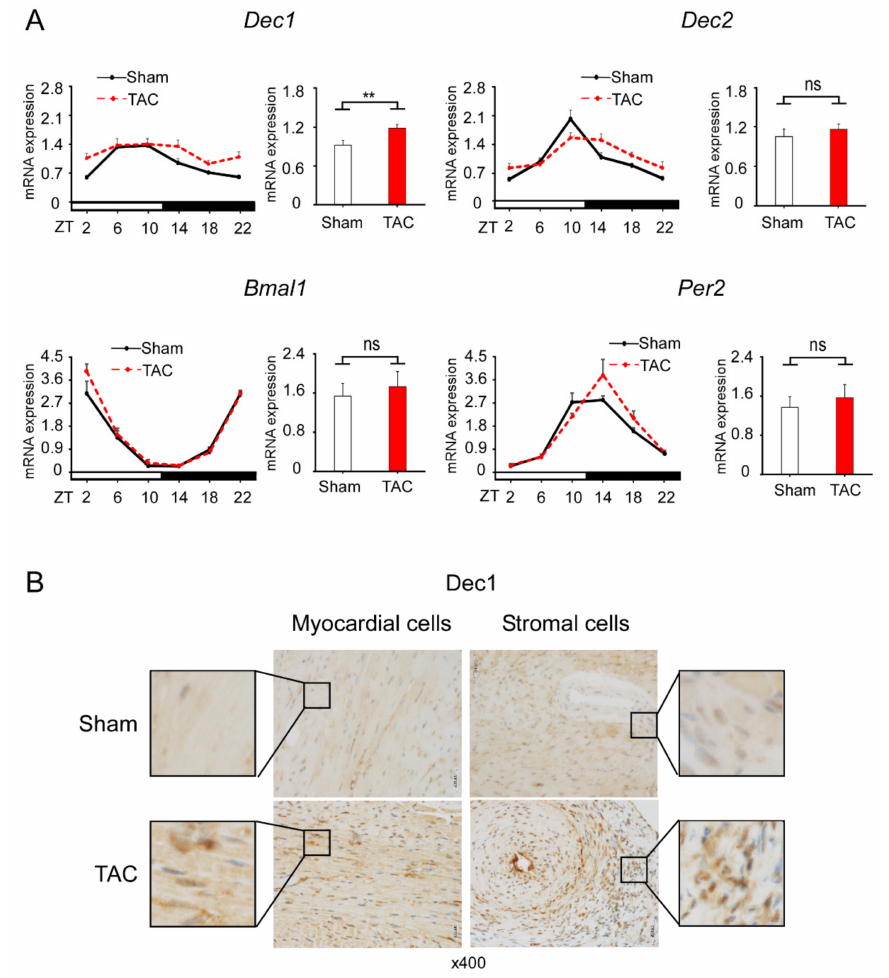
Figure 2. TAC increases Dec1 expression. ( A ) The circadian expression of clock genes in WT mice treated with TAC (red dotted line) and sham treatment (black line). The mRNA levels of Dec1 , Dec2 , brain and muscle aryl hydrocarbon receptor nuclear translocator-like protein-1 ( Bmal1 ), and period 2 ( Per2 ) were analyzed by real-time PCR. Each right graph shows average of total mRNA expressions from zeitgeber time 2 (ZT2) to ZT22 in sham and TAC mice. The circadian expression of clock genes was assessed by analyzing one-way ANOVA. Multiple comparisons between sham and TAC groups were analyzed by two-way ANOVA with Tukey–Kramer post hoc test. Comparison of two groups was analyzed by a two-tailed Student’s t -test. The number of mice was four or five mice per group per time point. Data are the means ± SEM. ** p < 0.01; NS: not significant; ZT: zeitgeber time with light on at 8:00 a.m. (ZT0) and light o ff at 8:00 p.m. (ZT12). ( B ) Immunohistochemical detection of Dec1 in myocardial and stromal cells. Representative images of one WT heart treated with TAC and sham at four weeks. The black square shows representative large images, magnification 400 ×